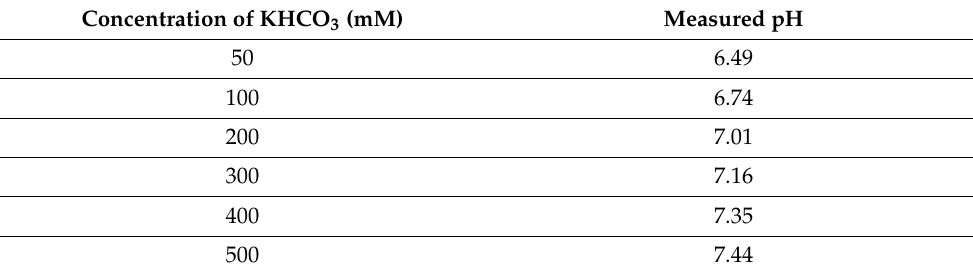
Table 1. Effect of concentration of KHCO 3 on final assay